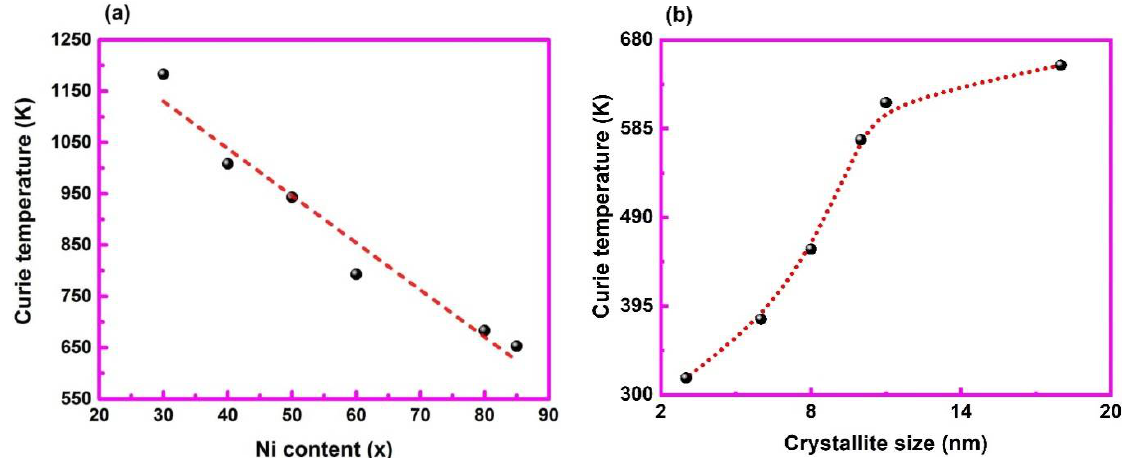
Figure 10. Curie temperature against Ni content and crystallite size for ( a ) Co 100−x Ni x NPs as a function of Ni content and for ( b ) Co 15 Ni 85 NPs milled at a speed of 1425 rpm for 100, 200, 300, 500, 1000 and 1200 min.